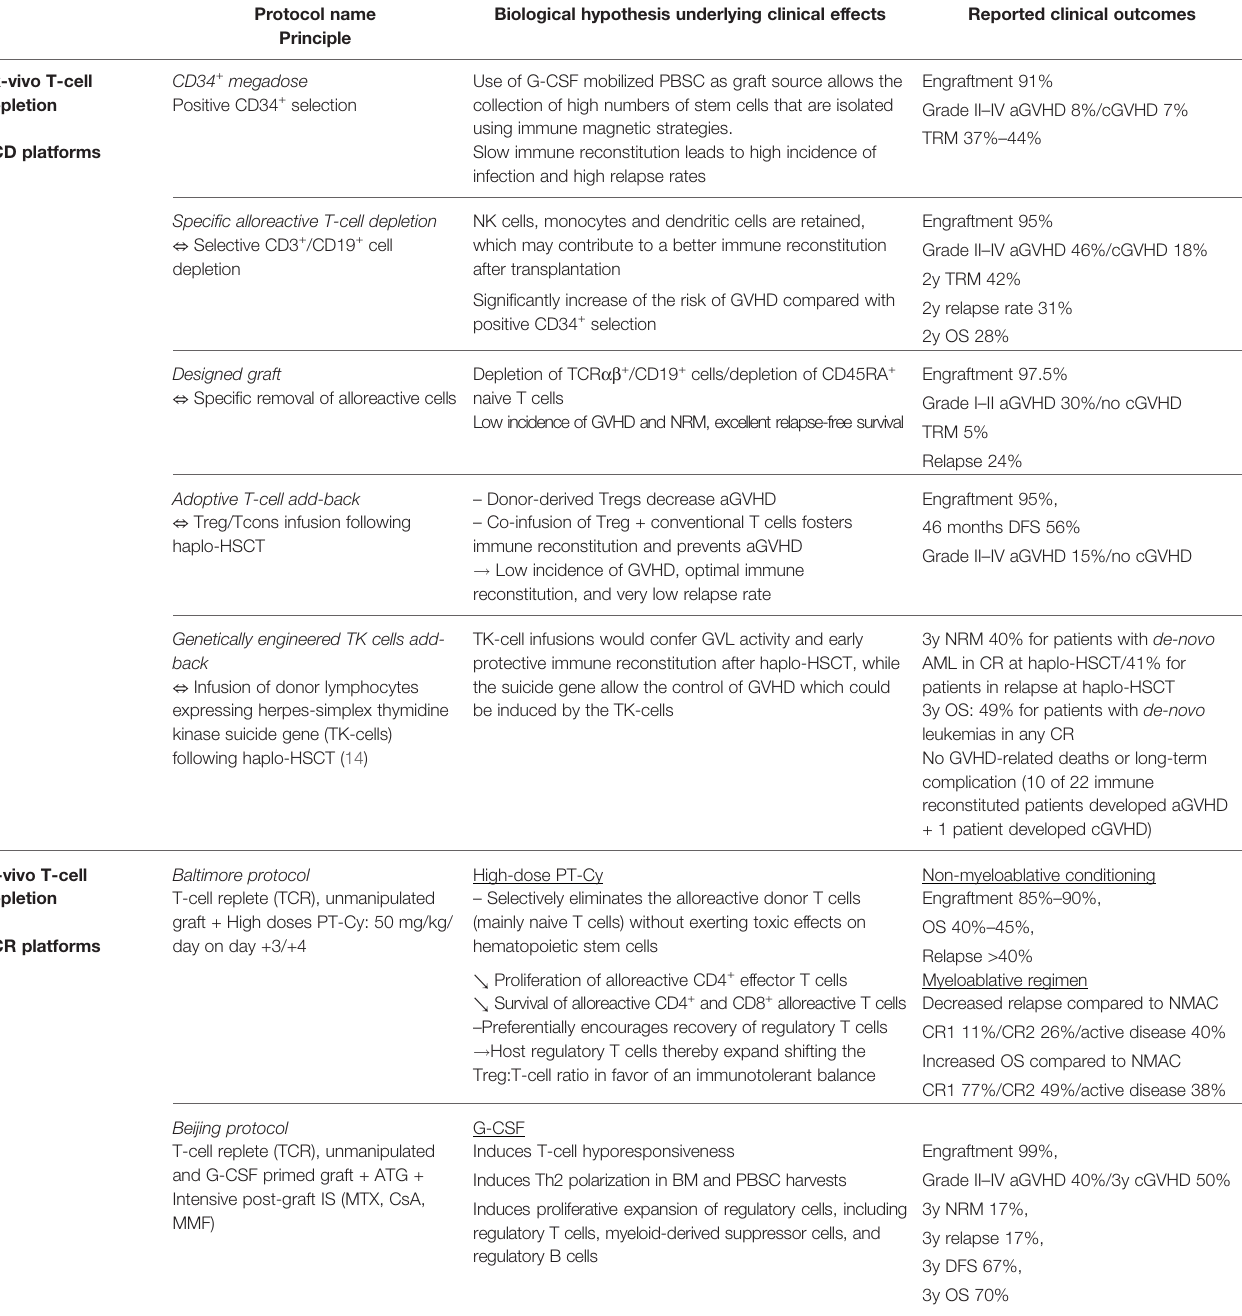
TABLE 1 | Comparison of current methods for T-cell